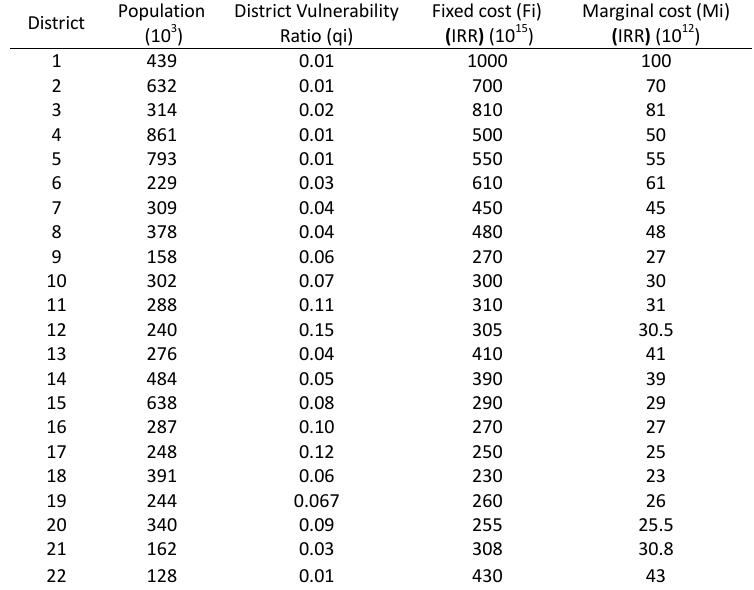
Table 1: District information of Tehran (Edrissi, et al., 2015) District